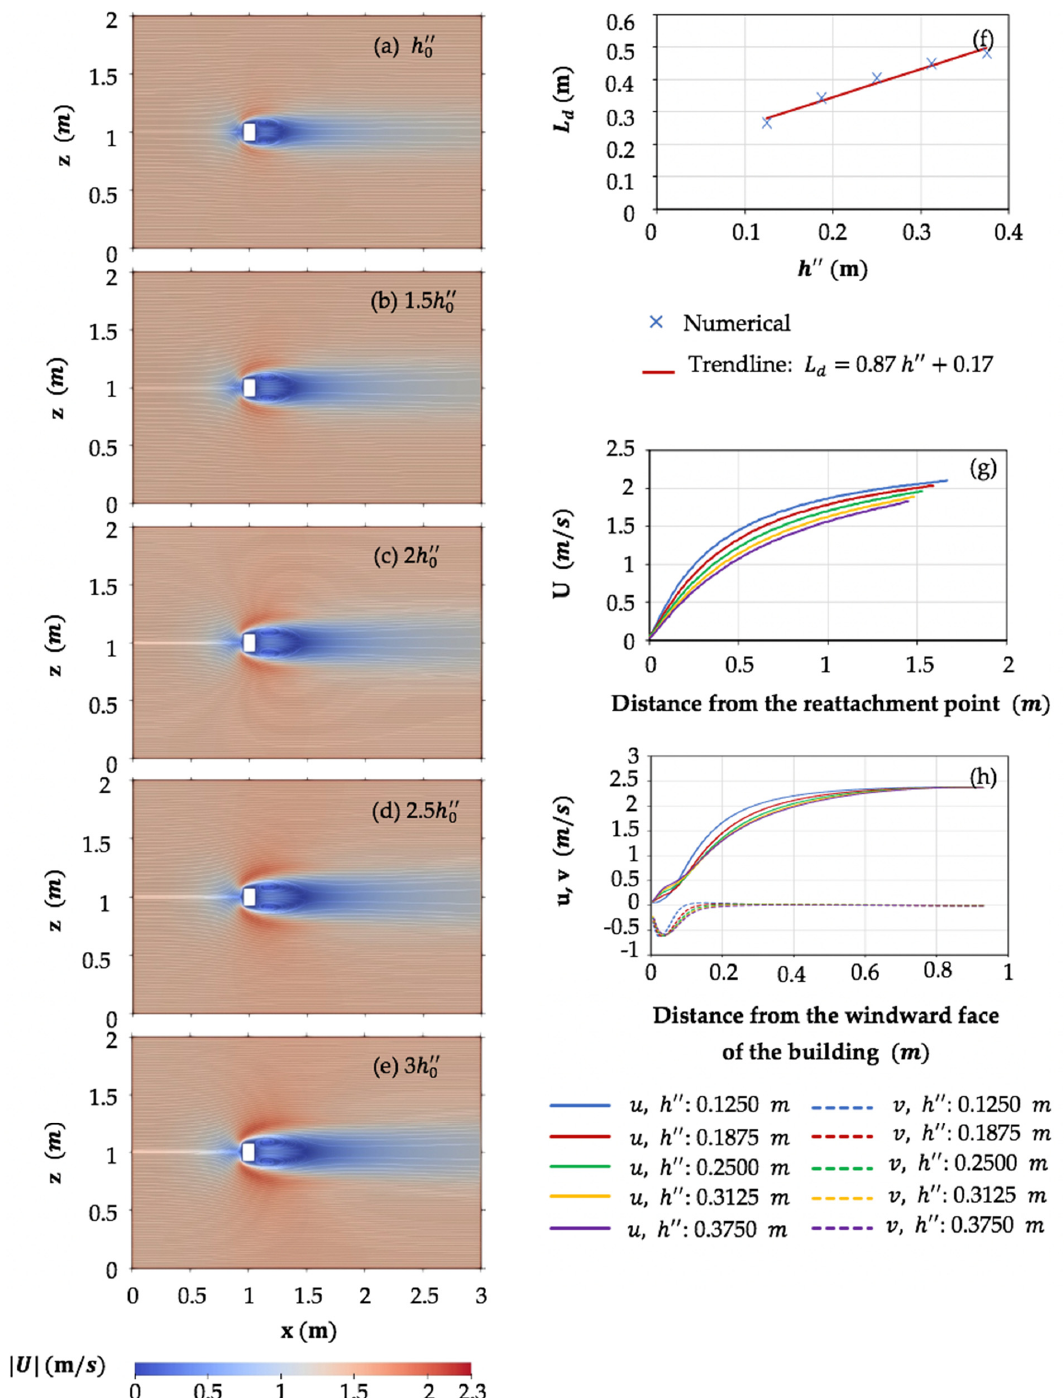
Figure 7. The impact of building height on ( a – e ) wind velocity magnitude (color) and direction (streamlines), ( f ) length of the downwind recirculation region, L d , just behind the leeward face of the building along the centerline, ( g ) wind velocity magnitude downstream of the building after flow reattachment along the centerline, and ( h ) wind velocity magnitude, streamwise, u , and vertical velocity components, v , upstream of the building along the centerline. Results are derived for a horizontal near-surface plane, y = 0.0125 m. The building length and width are l (cid:48)(cid:48) and w (cid:48)(cid:48) , respectively. 0 0 The building height, h (cid:48)(cid:48) , is varied as h (cid:48)(cid:48) , 1.5 h (cid:48)(cid:48) , 2 h (cid:48)(cid:48) , 2.5 h (cid:48)(cid:48) , and 3 h (cid:48)(cid:48) 0 0 0 0 0